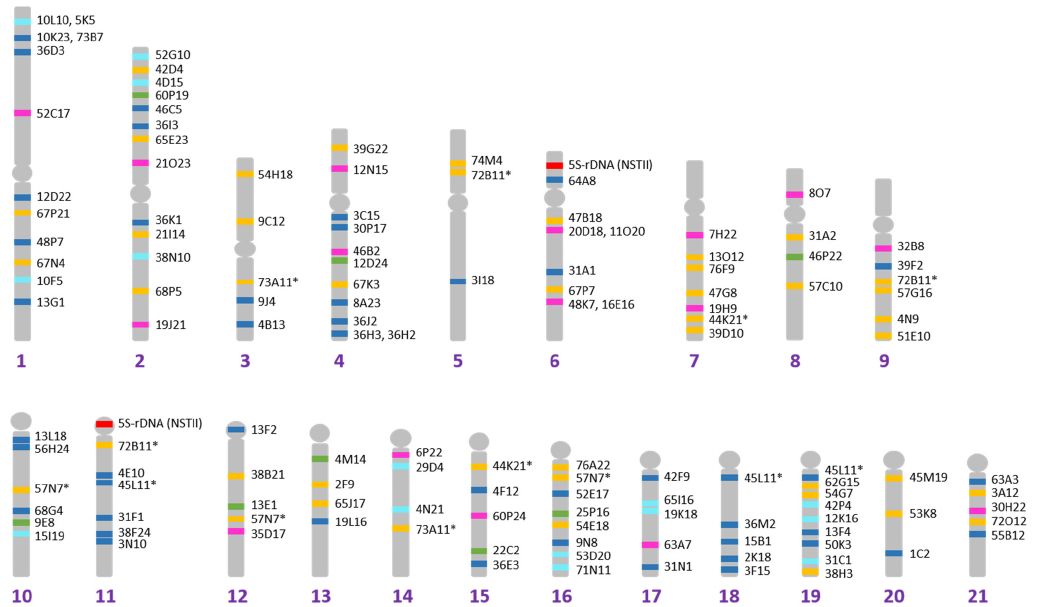
Figure 1. Cytogenetic map of Solea senegalensis obtained with BAC probes: Yellow color indicates BACs containing microsatellites; pink color indicates BACs with genes related to sexual reproduc- tion/differentiation; green color indicates BACs with genes related to metamorphosis; clear blue color indicates BACs containing genes related to the immune system; and dark blue color indicates BACs with genes belonging to other categories. Short arms are p and long are q (upper is p and lower is q in metacentrics). * BACs found on more than one chromosome. Table 1. Integration of the cytogenetic map of Solea senegalensis with published linkage map and physical